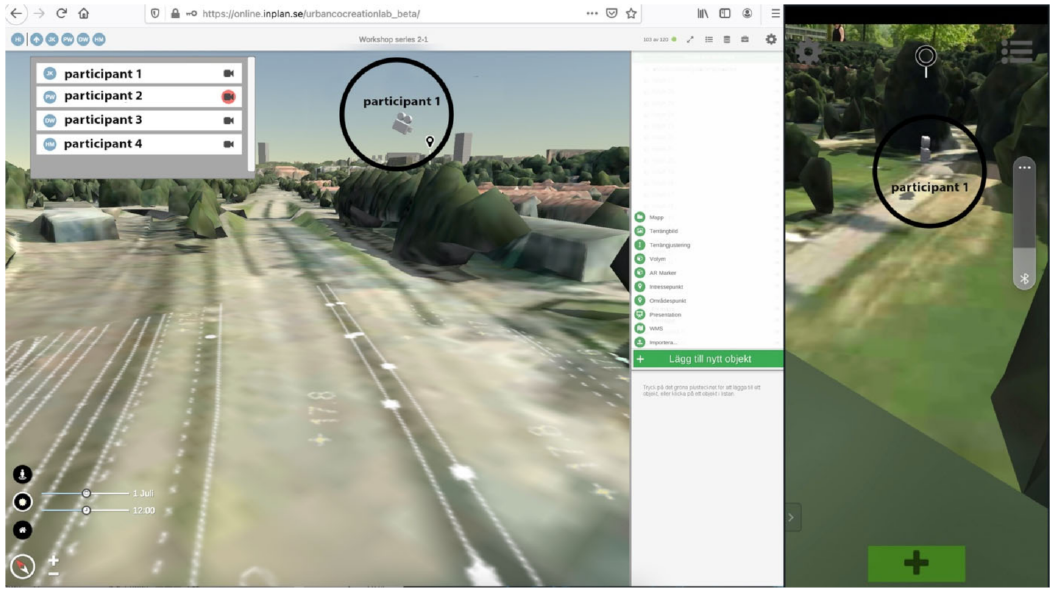
Figure 8. Participants can be seen in the form of a camera to show their location and their viewing direction. The web-based desktop version is seen to the left and MAR version to the